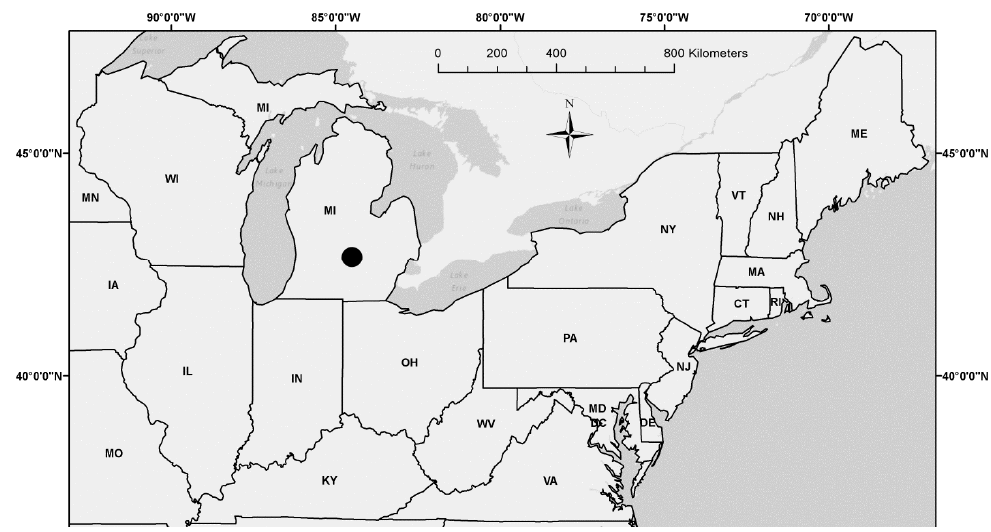
Figure 1. Hybrid aspen ( P. × smithii ) full-sib families sampled from a plantation located in Sandhill Research Area managed by Michigan State University ( ● ) in Ingham County, Michigan (MI). Standard state abbreviations shown for neighboring states in the Northeastern United States.